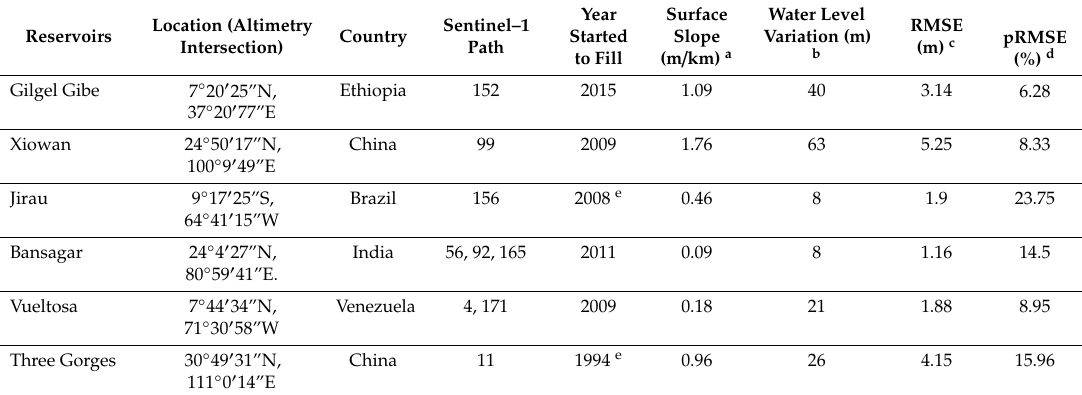
Table 1. List of reservoirs investigated in this study. See location map provided in Figure